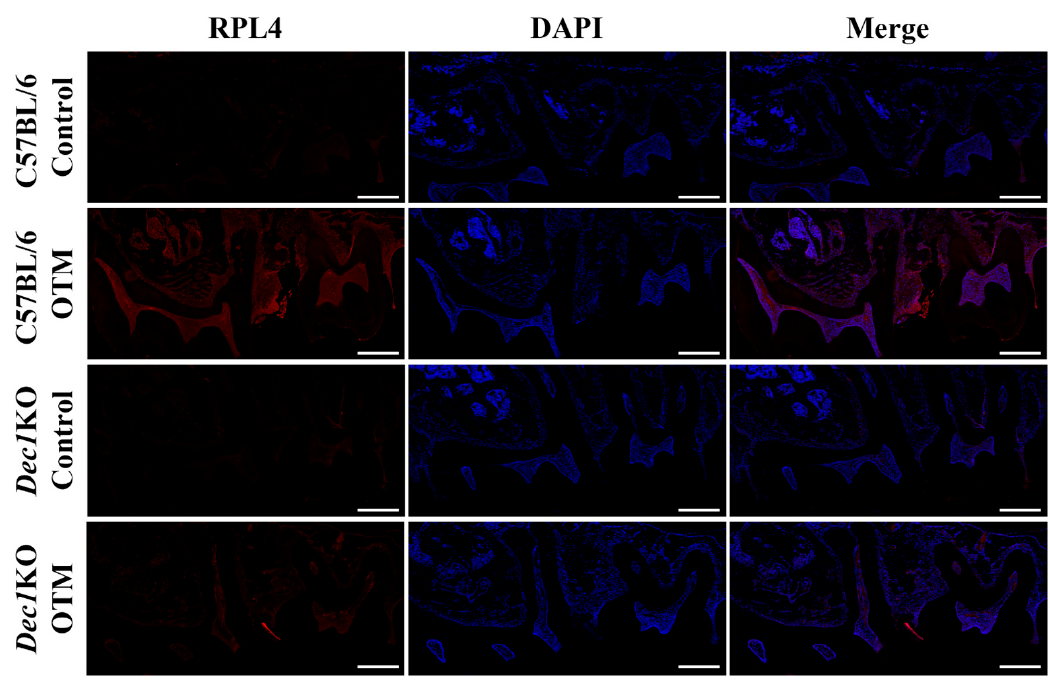
Figure 9. A deficiency of Dec1 reduces the expression of RPL4 in the OTM mouse model. Immunofluorescence analysis shows that the expression level of RPL4 decreased in Dec1 KO OTM mice compared with WT OTM mice. Scale bars = 100 μ m. All results are representative of at least three independent experiments.